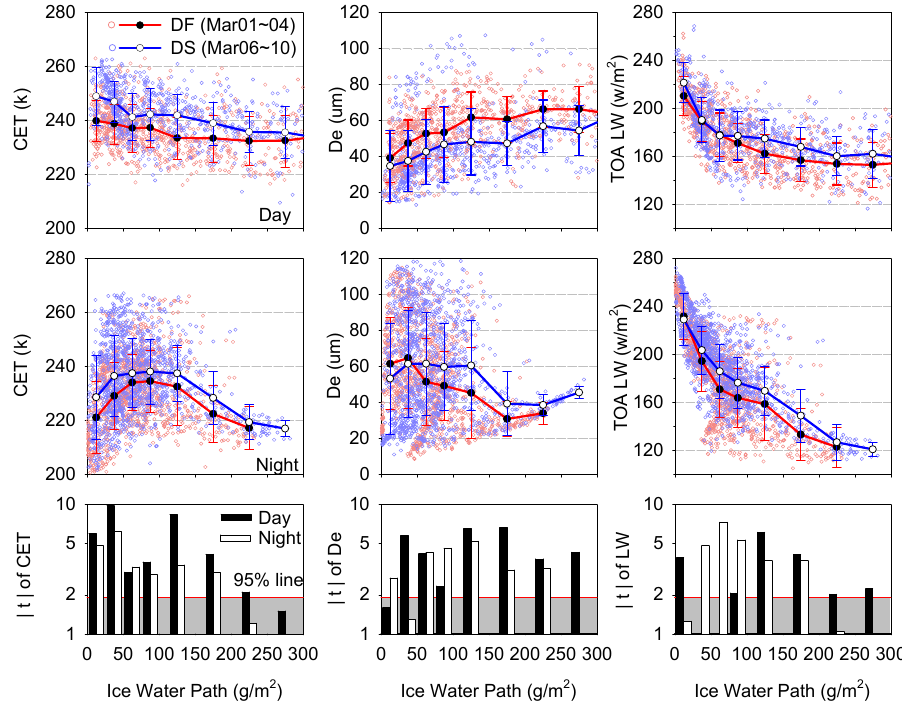
Fig. 4. FM3 and FM4 CERES observed/retrieved cloud effective temperature (CET, left panel), ice effective diameter (De, central panel) and upward longwave radiation flux (TOA LW, right panel) against ice water path (IWP) during day time (upper row) and nighttime (mid row). The t -test of difference of each parameter at given IWP between dust free (DF) and dust (DS) conditions are shown in the bottom row.